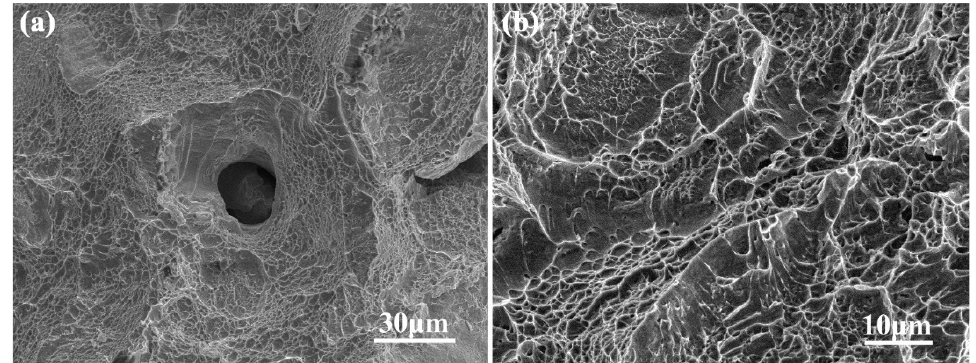
Figure 17. The ( a ) low and ( b ) high magnification SEM images of fracture surfaces of vertical sample H-Z of SLMed Ti-55511 alloy at room